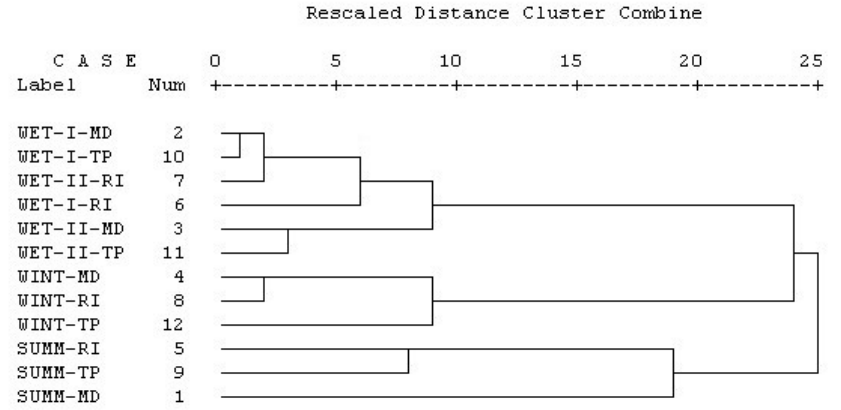
FIGURE 5. Dendrogram depicting the clustering based on community composition across habitats and seasons. SW= southwest; NE = northeast; MD = moist-deciduous; RI = riverine; TP = teak plantation.